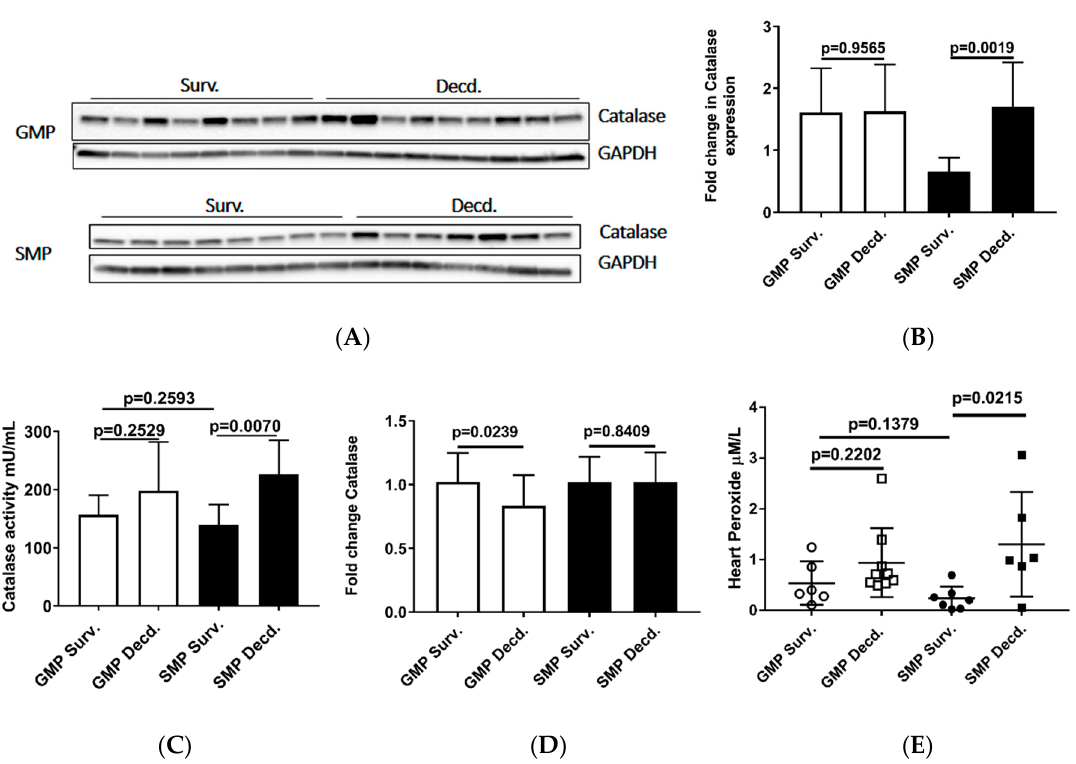
Figure 5. Analysis of Catalase and Peroxide in the heart protein extracts from irradiated survivor and decedent GMP / SMP. ( A ) Western blot analysis of Catalase expression in heart lysates of irradiated survivor or decedent SMP / GMP. β -Tubulin is shown as loading control. ( B ) Statistical analysis of Western blot bands intensity following normalization to GAPDH as loading control. ( C ) Measurement of Catalase enzymatic activity in heart protein extracts from irradiated survivor or decedent GMP / SMP. ( D ) Quantitative PCR analysis of catalase transcripts in hearts from irradiated survivor or decedent GMP / SMP. ( E ) Graph representing the Peroxide levels measured in heart lysates of irradiated survivor or decedent SMP / GMP. Each solid circle or square represents measurement from one individual animal.